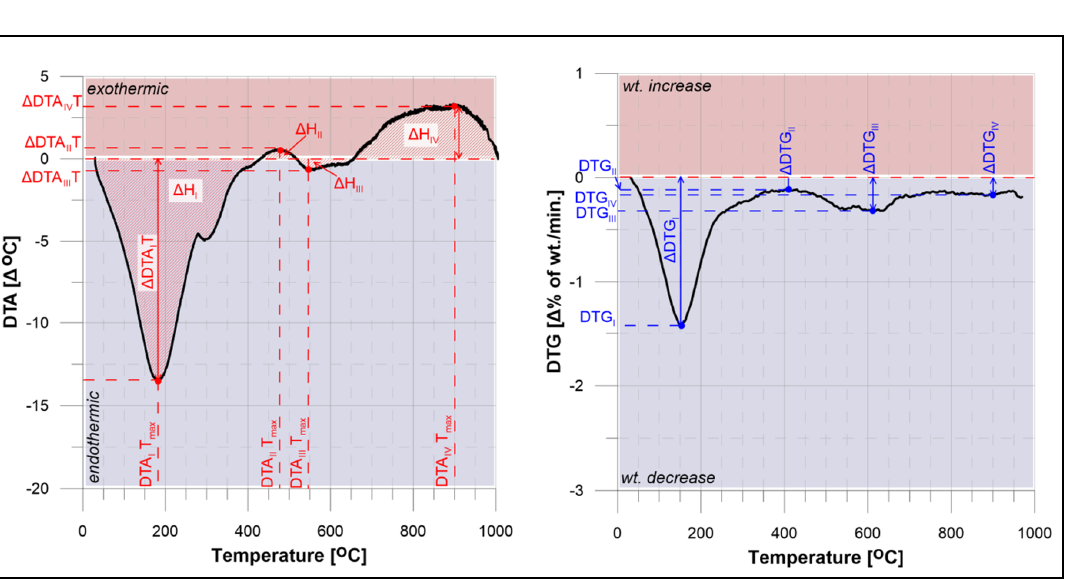
Figure 4. Schematic representation of differential thermal analysis (DTA) and differential Schematic representation of di ff erential thermal analysis (DTA) and di ff erential thermogravimetry (DTG) parameters. Subscript numbers indicate thermal effects described in detail thermogravimetry (DTG) parameters. Subscript numbers indicate thermal e ff ects described in detail in in Section 4.1.2. Section